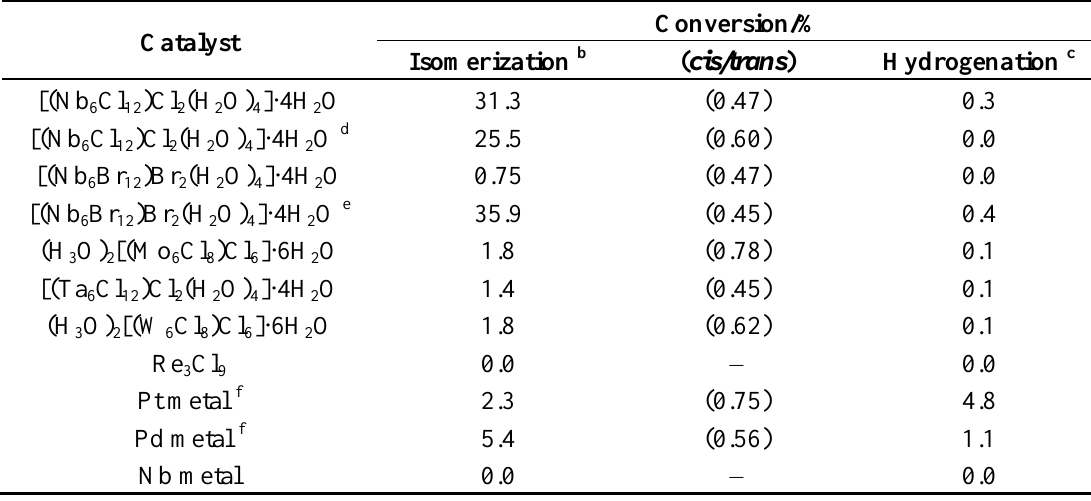
Table 4. Isomerization of 1-hexene over halide clusters a .